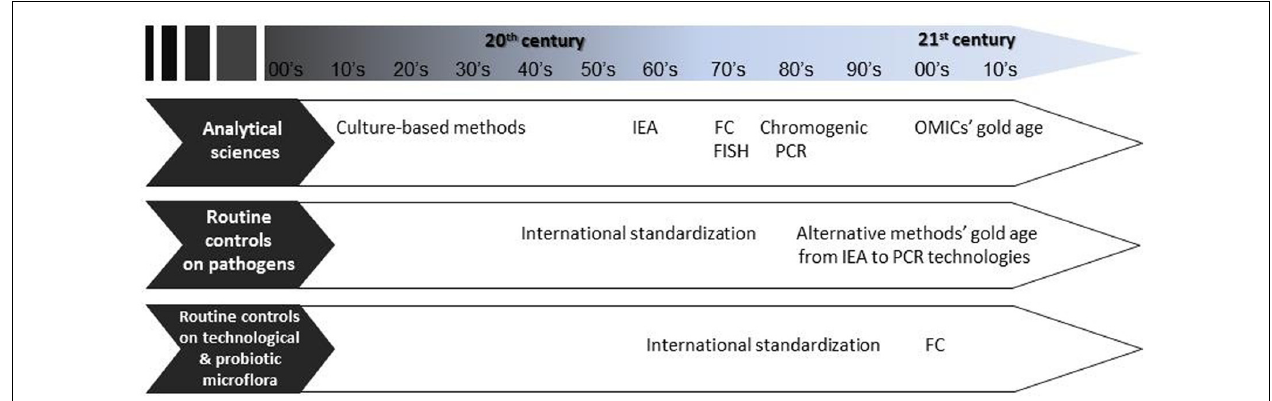
FIGURE 1 | Evolution of analytical methods, and the gaps between routine controls depending on the targeted microbiota. IEA, immuno-enzymatic assay; FC, flow cytometry; FISH, fluorescent in situ hybridization; PCR, polymerase chain